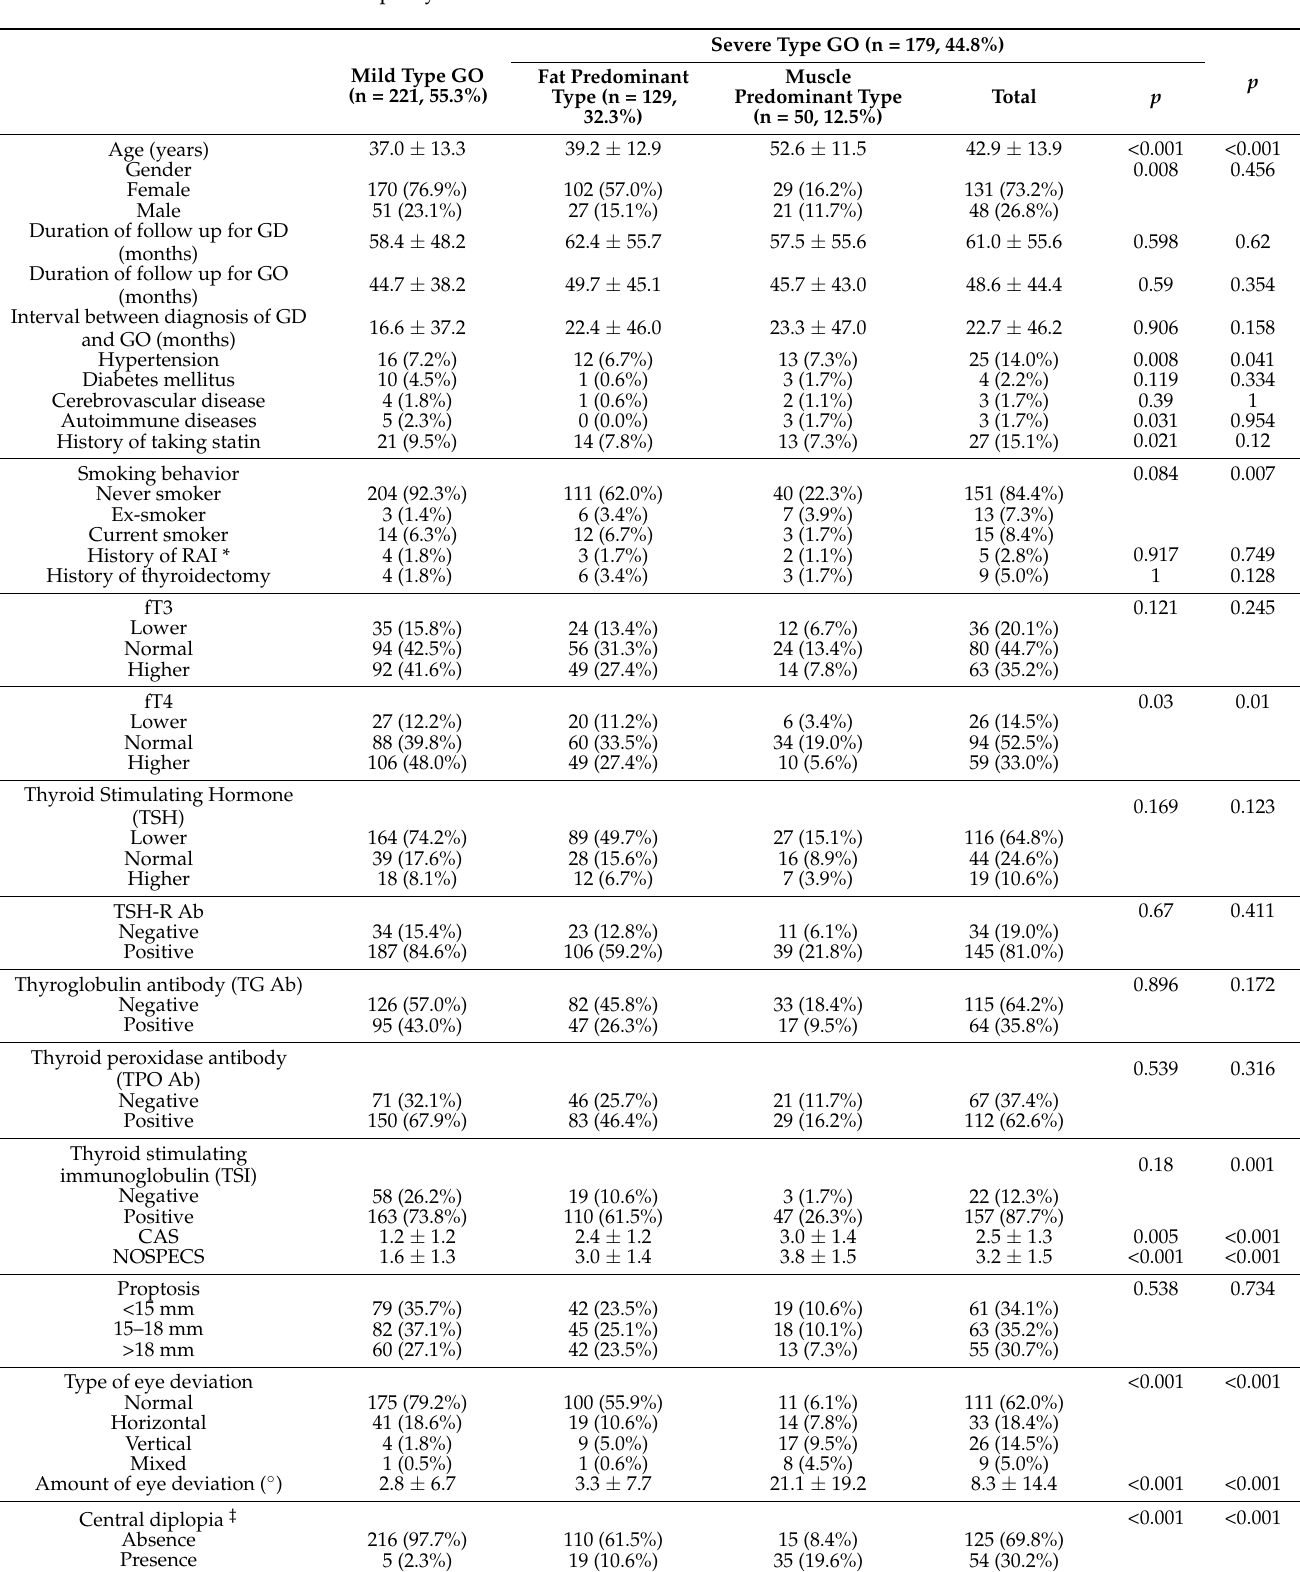
Table 1. Baseline characteristics at initial examination of 400 patients with Graves’ disease and Graves’